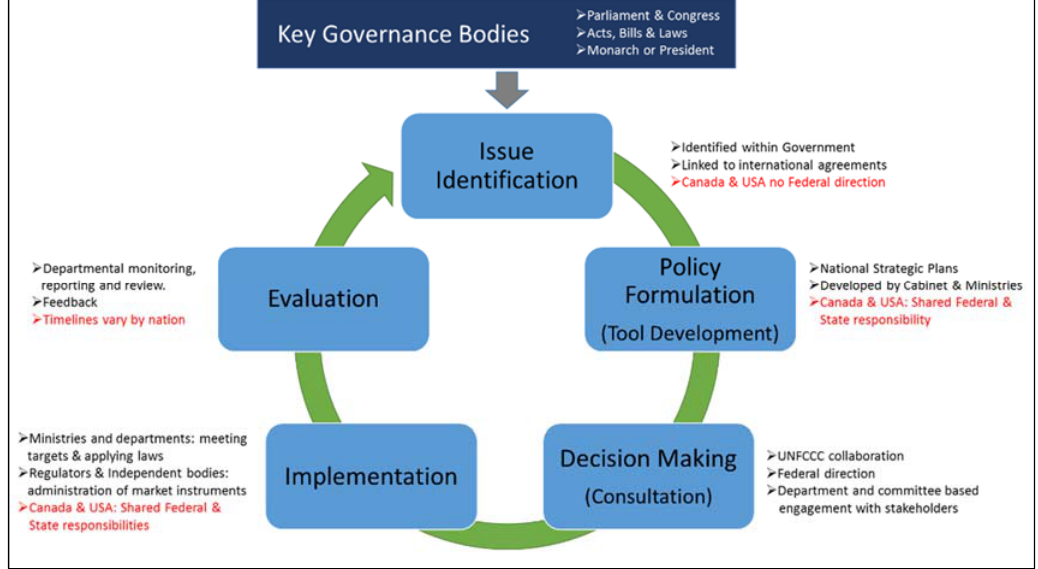
Figure 3. OECD governance and policy making process (sub ‐ steps in parentheses).